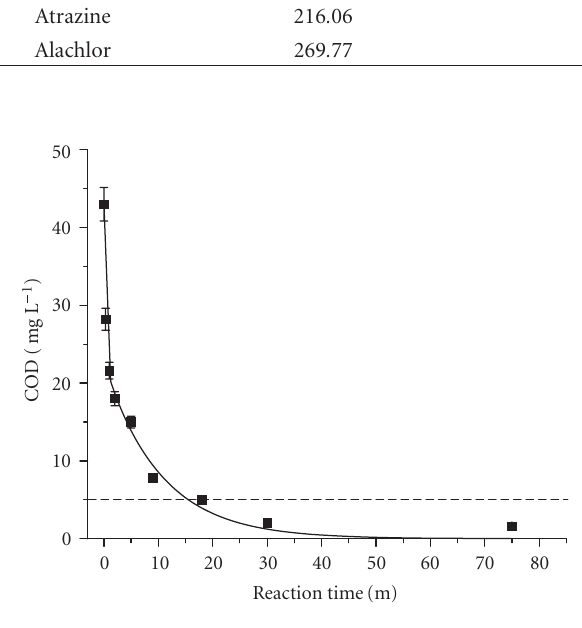
Figure 5: COD abatement of a solution 0 . 119 mmol L − 1 chlorbro- muron as a function of solar irradiation time in the presence of TiO 2 . The best fit (—) of the experimental data ( (cid:2) ) was for an ex- ponential decay second-order equation. The dashed line represents the determination limit of COD method.